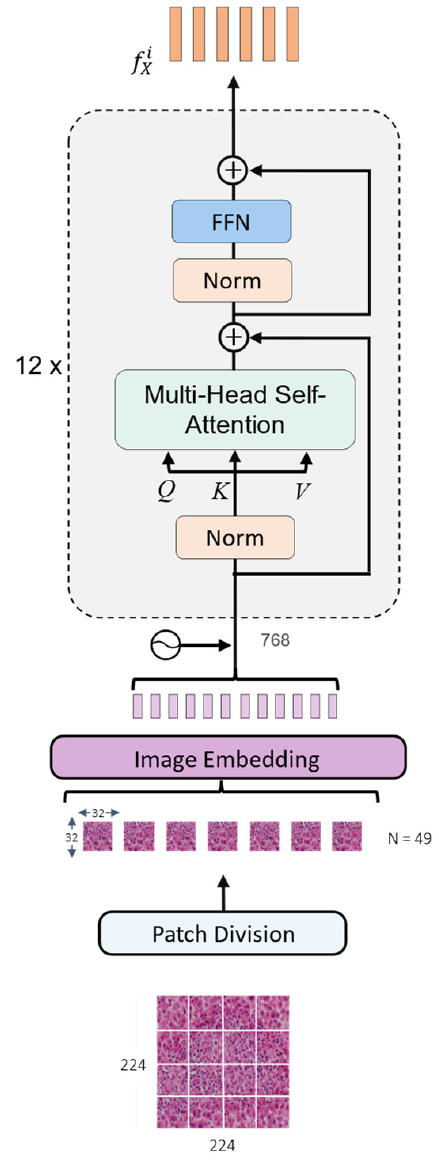
Figure 2. The architecture of the image encoder.